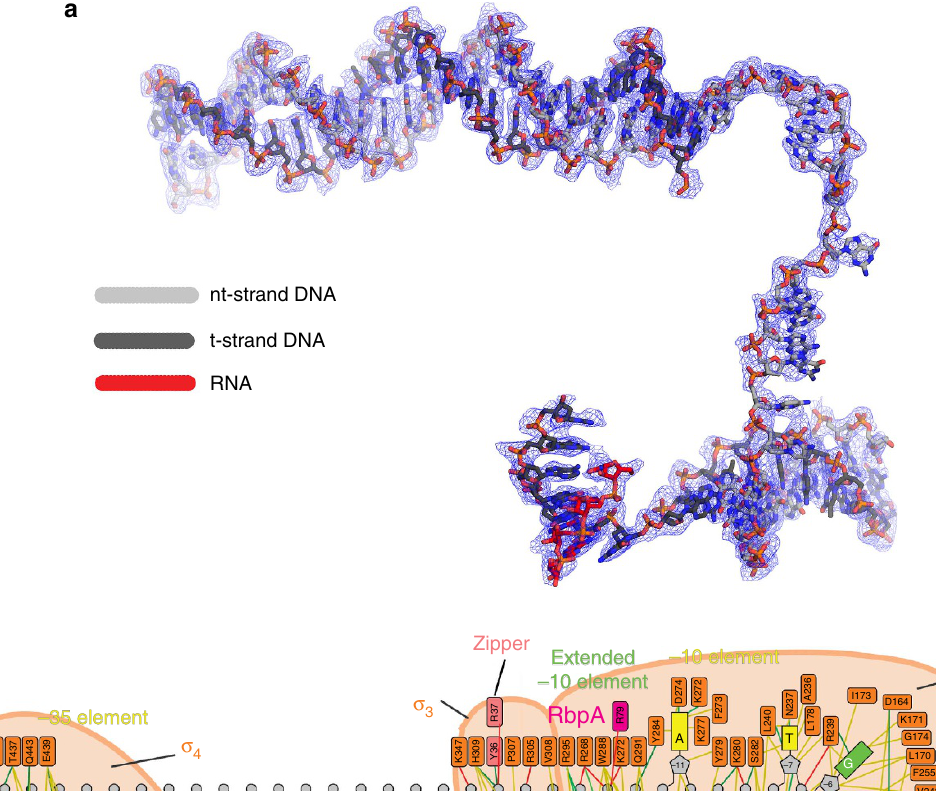
Figure 2 | Msm RPo electron density and protein–DNA interactions. ( a ) Electron density and model for RPo nucleic acids. Blue mesh, 3.2Å resolution 2 F o (cid:2) F c map for nucleic acids (contoured at 1.0 s ). ( b ) The nucleic acids shown are from the RPo structure (Fig. 1a). The protein–DNA interactions for the (cid:2) 10 element and upstream were derived from the 2.76Å-resolution Msm RbpA/E s A /us-fork complex (PDB ID 5VI8) 4 , but only a small handful of these interactions differed in the 3.2Å-resolution RPo structure. The protein/nucleic acid interactions for nucleic acids downstream of the (cid:2) 10 element were derived from the 3.2Å-resolution RPo structure (Figs 1b and 2a). The t-strand DNA from (cid:2) 7 to (cid:2) 11 was disordered and not modelled. Protein/DNA interactions were defined as follows: van der Waals ( r 4.5Å), yellow lines; H-bonds ( r 3.5Å); salt bridges ( r 4.5Å), red lines.